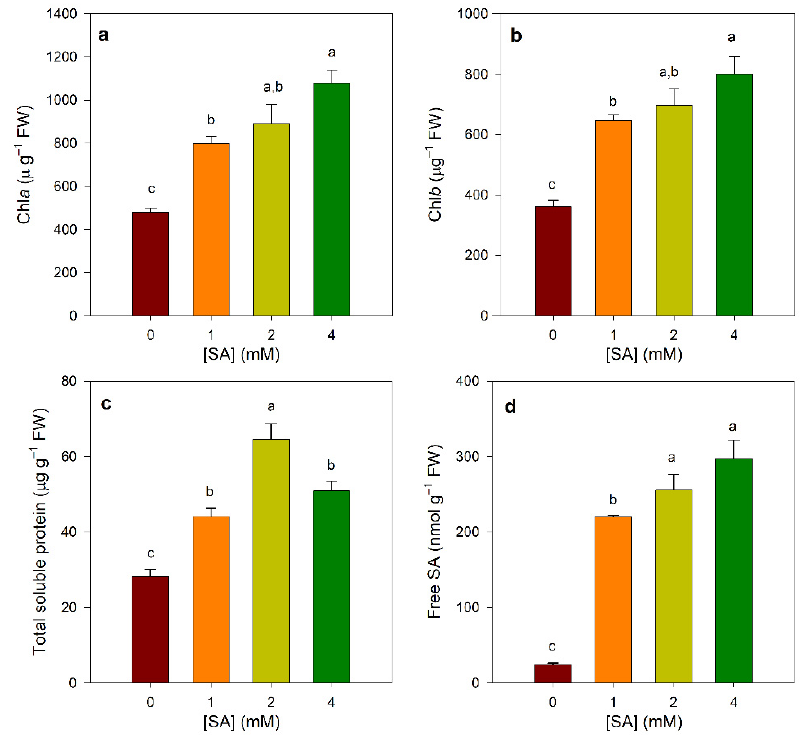
Figure 1. Effect of foliar SA application on chlorophylls ( a , b ), total soluble proteins ( c ), and endogenous SA levels ( d ) in leaves of 45-day-old okra plants. The data are means ± SE from n = 16 from two experiments. Different letters indicate significant difference at p ≤ 0.05 (Tukey’s HSD post hoc test). F -values and level of significance from ANOVA: chla, 18.54 ***; chlb, 20.33 ***; total soluble proteins, 13.32 ***; and SA, 2667.72 *** (*** p ≤ 0.001).